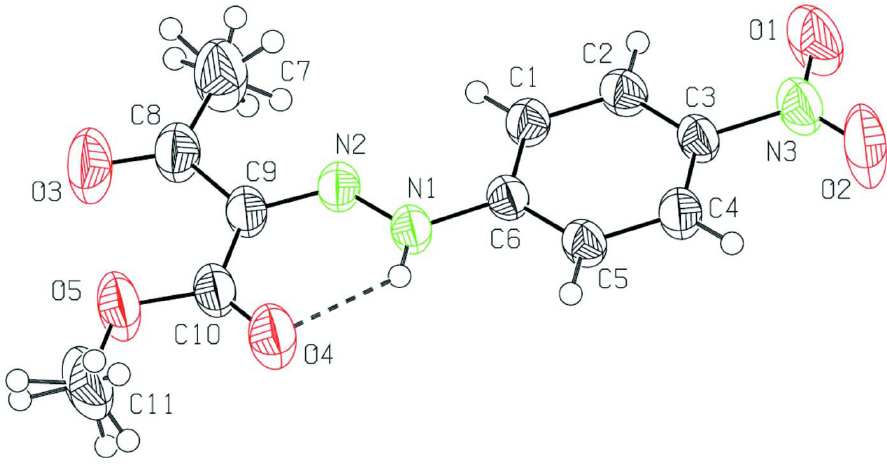
Figure 1 The molecular structure of the title compound, showing 30% probability displacement ellipsoids. Disorder of the two methyl groups are indicated and the N–H···O intra-molecular hydrogen bond shown as dashed lines.